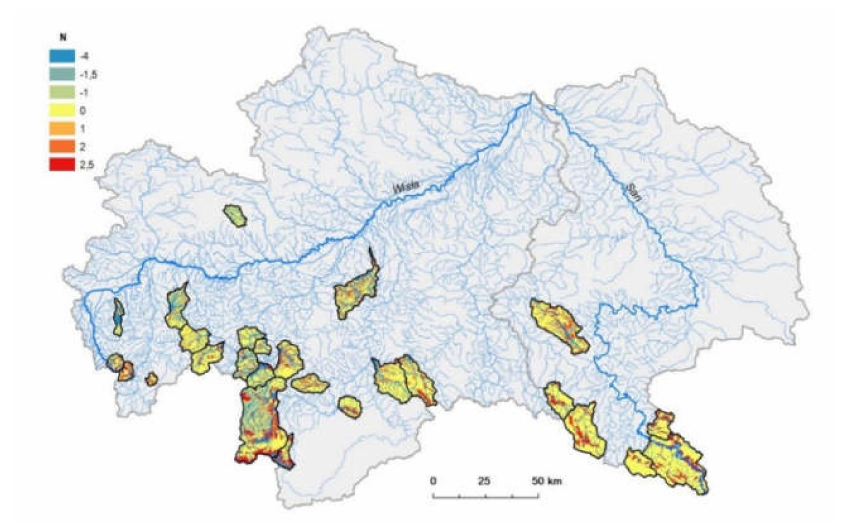
Figure 9. Non-forest ( N ) of analyzed catchments in the Upper Vistula